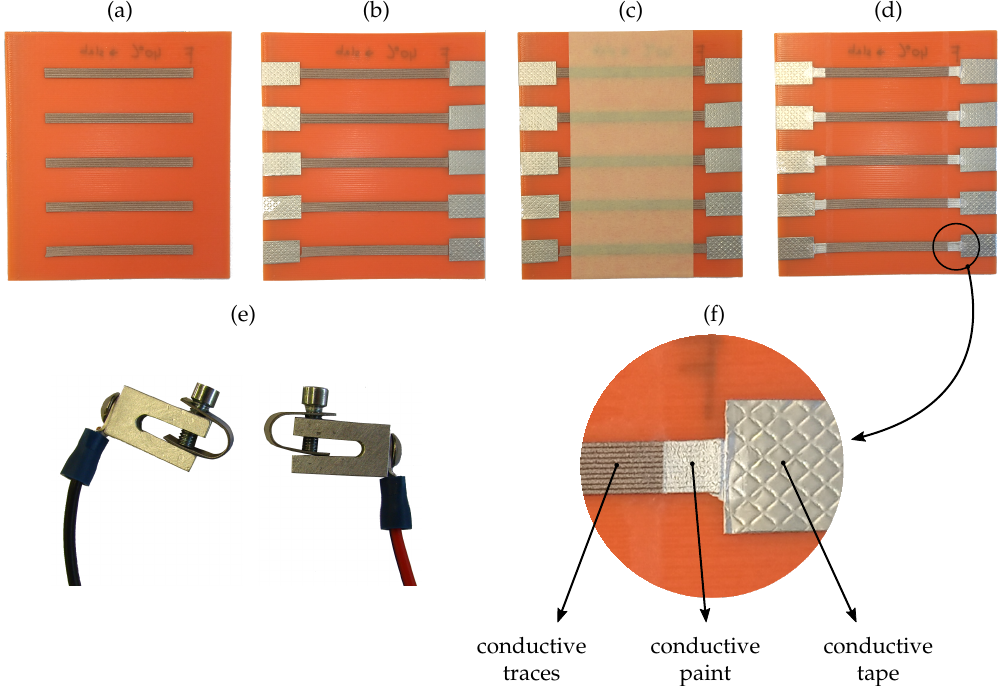
Figure 9. Preparation of electrical contacts: ( a ) printed sample board, ( b ) application of conductive tin-plated copper foil, ( c ) application of protective 50mm tape, ( d ) application of silver conductive paint, ( e ) contacting claps, ( f ) magnified electrical